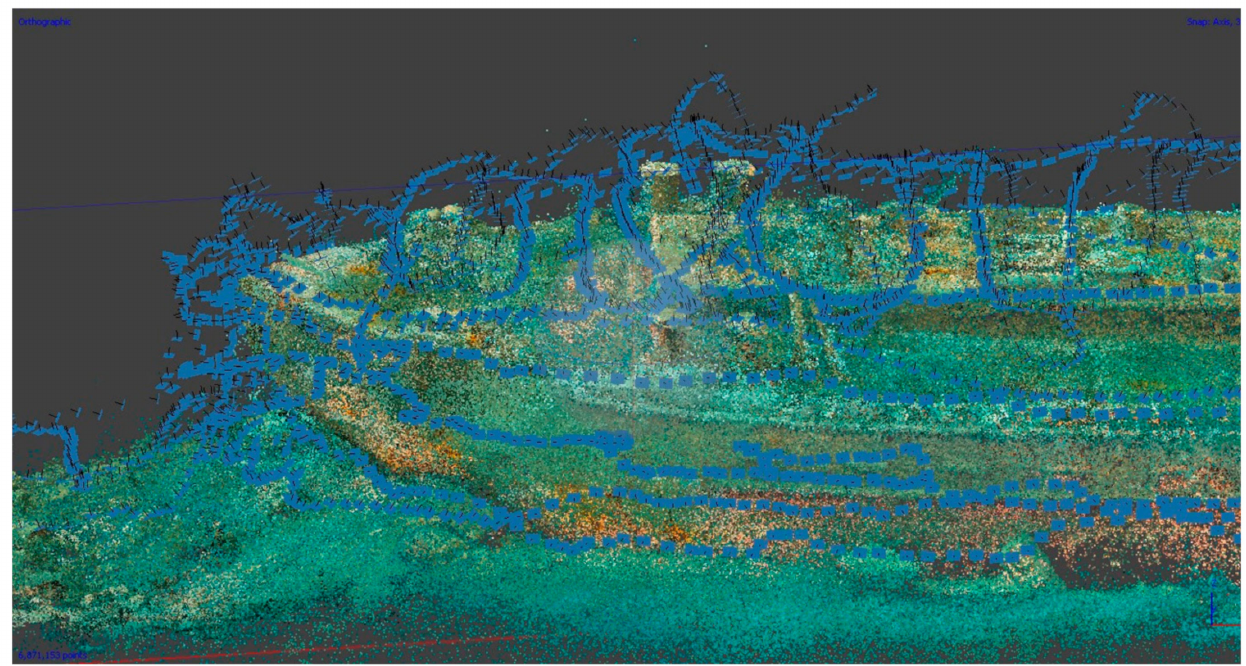
Figure 5. Part of the sparse cloud and camera positions for the X127 wreck